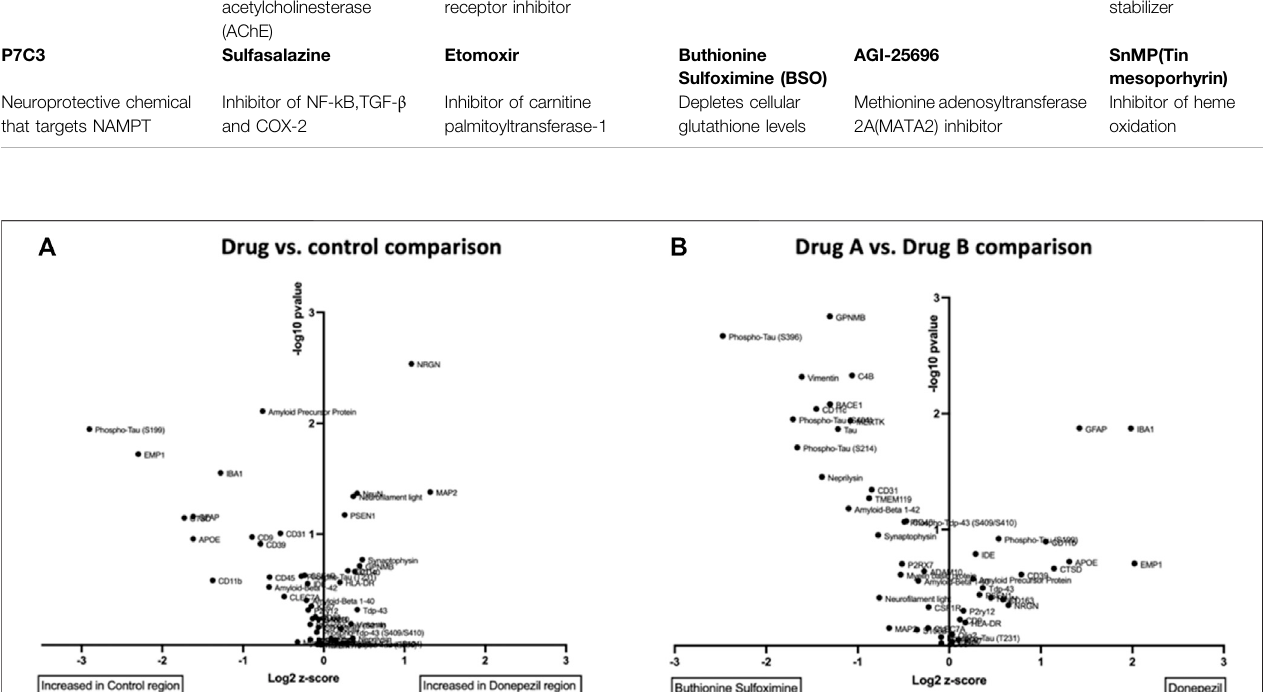
FIGURE 5 | (A) Volcano plot comparisons of expression of 56 protein markers in brain region treated with Donepezilvs control in TG model after drug exposure of 7 days (B) Directcomparisonofmarkerexpressionbetweentwodrugs,DonepezilversusBSOinTGmodel.Eachunitincreaseon x -axisrepresentsadoublinginmarker intensity. The y -axis shows the associated p -value (-log 10 ) across the biological replicate set of n = four to